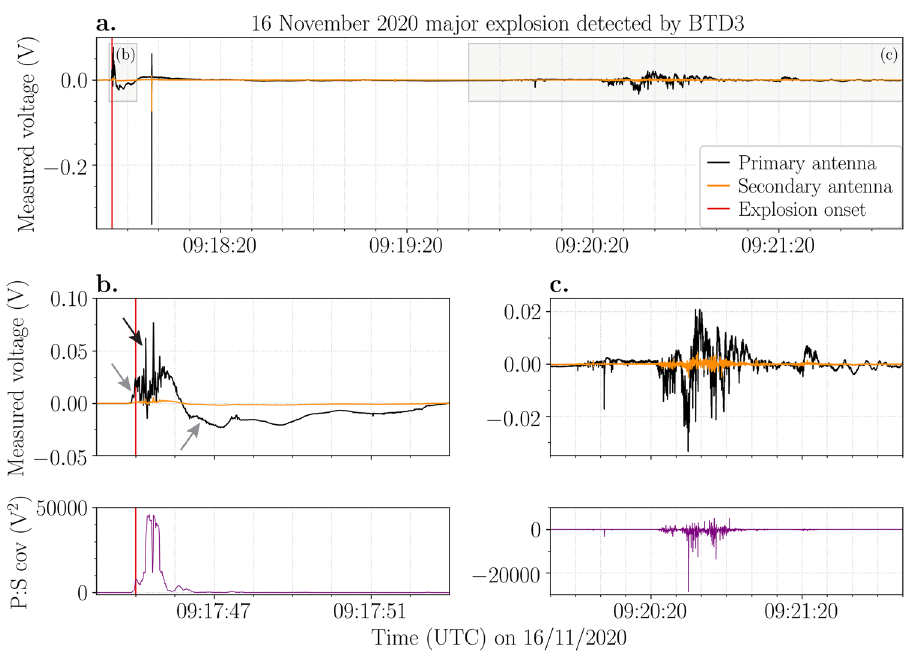
Figure 4. ( a ) Voltage (V) measured by the primary (black line) and secondary (orange line) antennas of BTD3 during the 16 November 2020 major explosion. The red vertical line indicates the explosion onset. ( b ) Movement of charge (grey arrows) and electrical discharges (black arrow) were detected almost immediately at the start of the explosion. The corresponding covariance (V 2 ) between the primary and secondary signals is shown below. ( c ) Electrical signal likely caused by ash impact transients as confirmed by the corresponding negative covariance